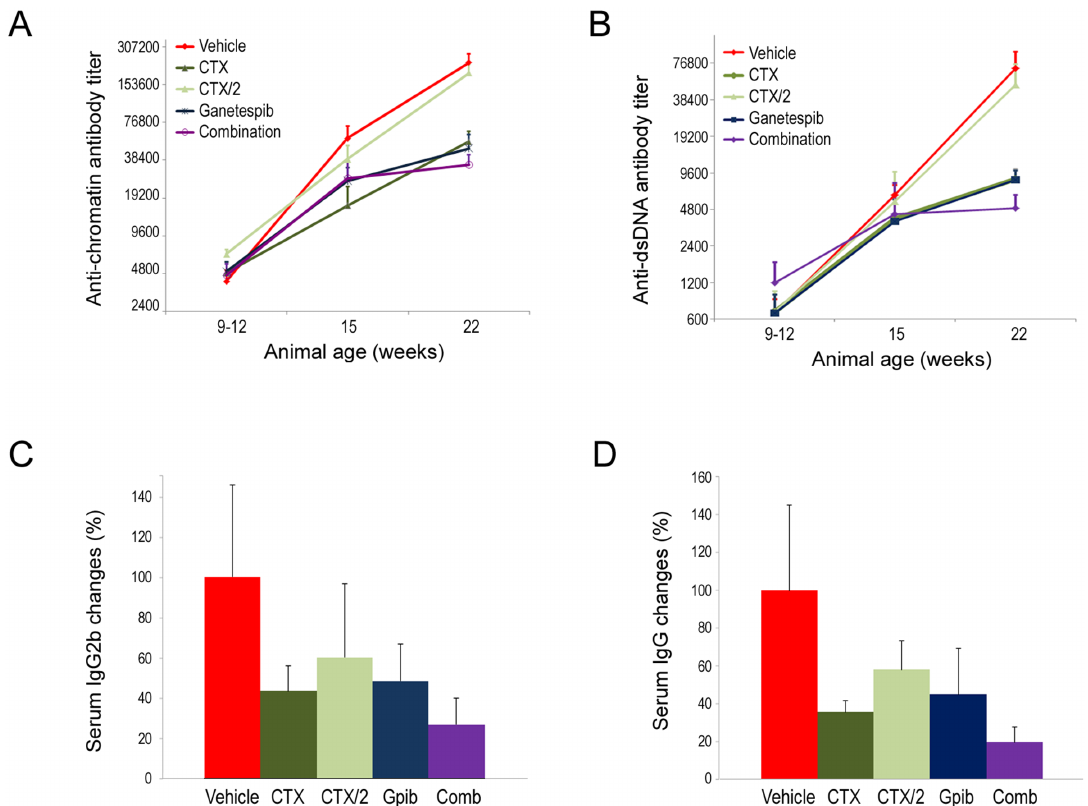
Fig 4. Combination ganetespib plus intermittent cyclophosphamide treatment effectively inhibits autoantibody production. Anti-chromatin (A) and anti-dsDNA (B) autoantibody titers were measured at three time points: upon initiation of therapeutic dosing (9 – 12 weeks of age); week 15; and at week 22. Average titers per treatment group ( ± SE) are presented. All treatment regimens except intermittent cyclophosphamide dosing alone (CTX/2) suppressed progressive age-related elevations in serum autoantibody levels. Inverse titers are shown. (C) Percentage changes in serum IgG2b levels ( ± SE) per treatment group. Gpib , ganetespib; Comb , combination (D) Percentage changes in total serum IgG levels ( ± SE) per treatment group. All reductions reached statistical significance compared to vehicle-treated control animals (p < 0.05). Gpib , ganetespib; Comb , combination